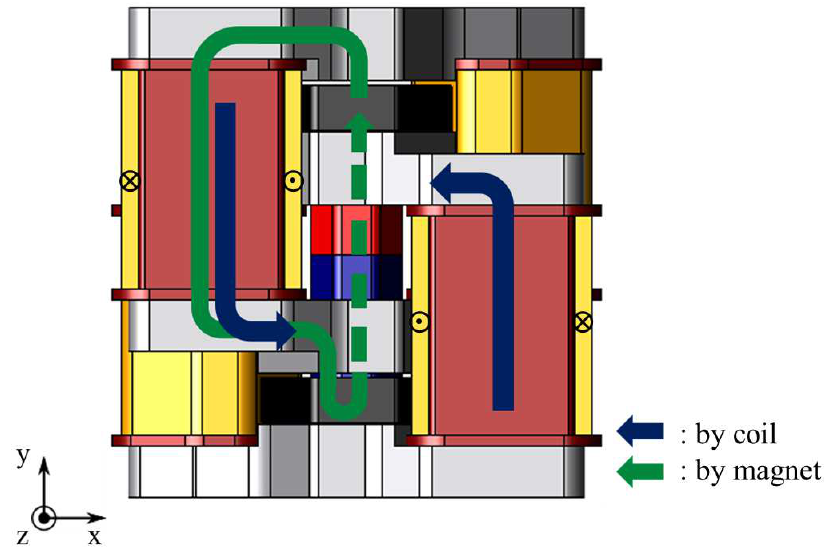
Figure 2. Operating